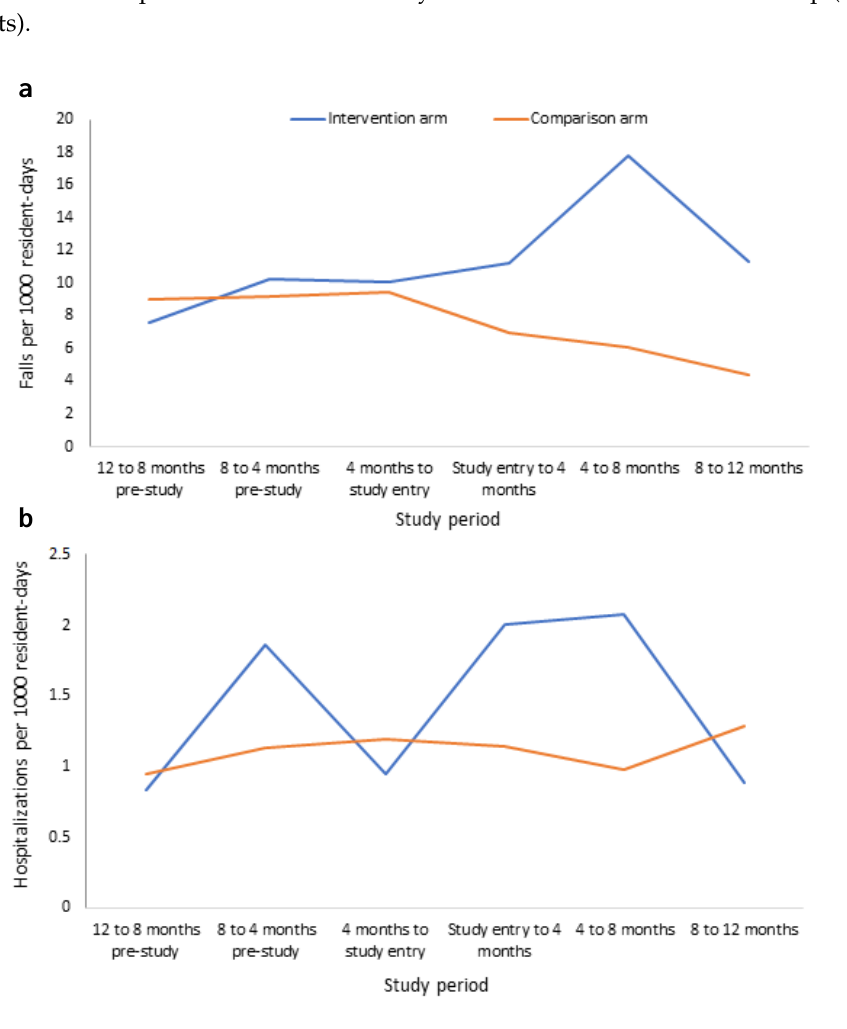
Figure 3. Falls ( a ) and hospitalizations ( b ) per 1000 resident days in the 12 months before and after study entry, stratified by study arm.